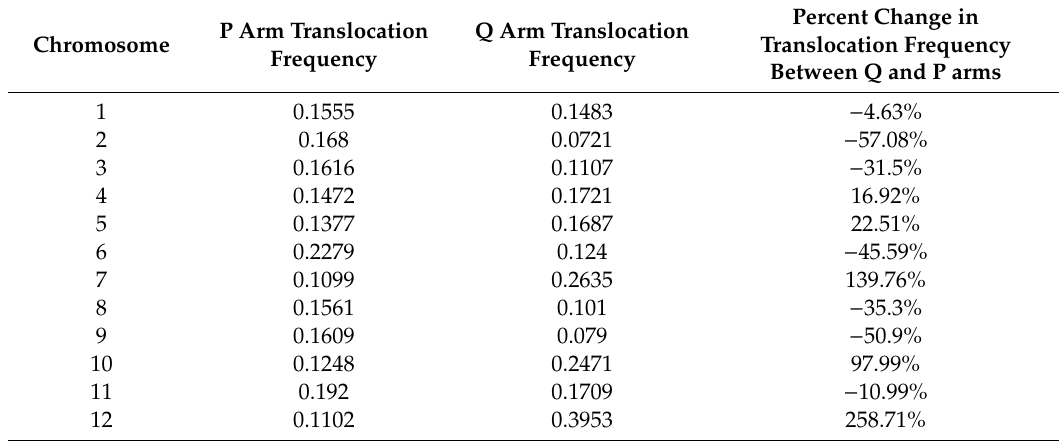
Table 3. Translocation frequency of chromosome